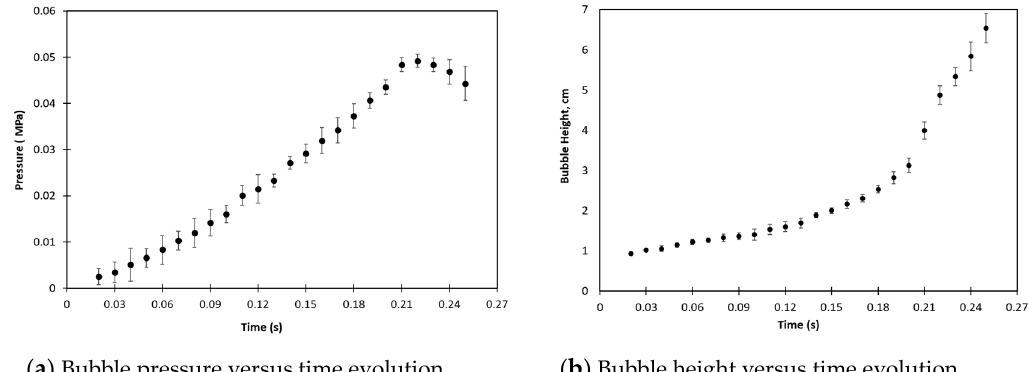
Figure 3. Bubble pressure and bubble height versus time evolution.